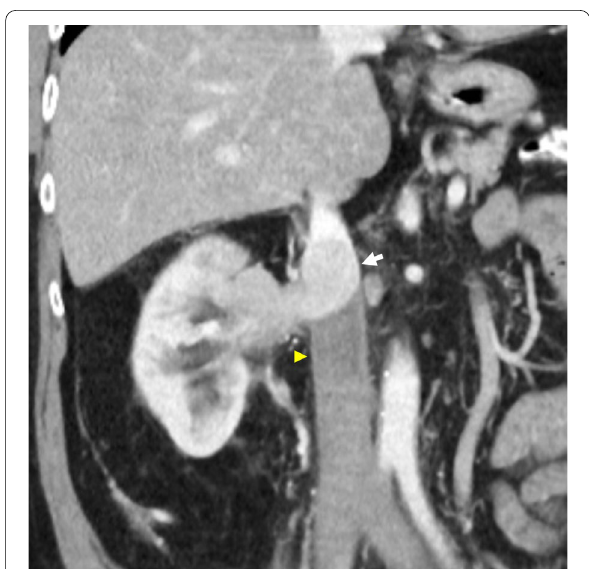
Fig. 15 Renal cell carcinoma with Mayo level II tumour thrombus and infrarenal bland thrombus. Coronal CT demonstrates occlusive enhancing tumour thrombus (arrow) extending from the right renal vein into the suprarenal IVC. Infrarenal IVC (arrowhead) and iliac vessels show no contrast enhancement and are expanded in keeping with bland thrombus